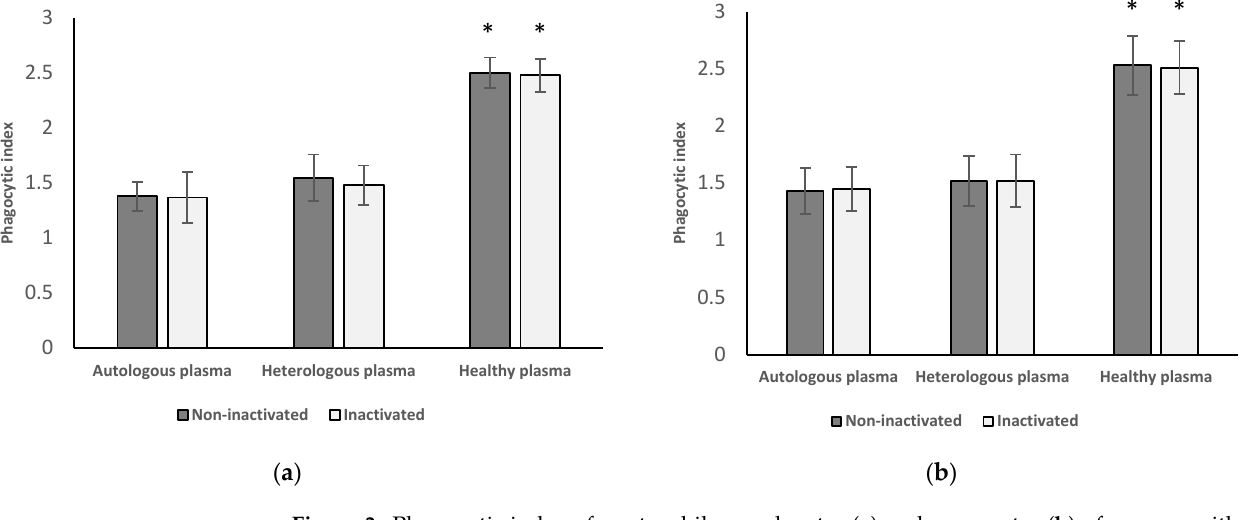
Figure 3. Phagocytic index of neutrophil granulocytes ( a ) and monocytes ( b ) of women with endo- metriosis before surgery followed by the treatment with autologous and heterologous plasma from the same group of patients and with plasma from women with endometriosis after surgery. Exper- iments were performed with inactivated and non-inactivated plasma samples in each group. * p < 0.001 compared with autologous and heterologous group.